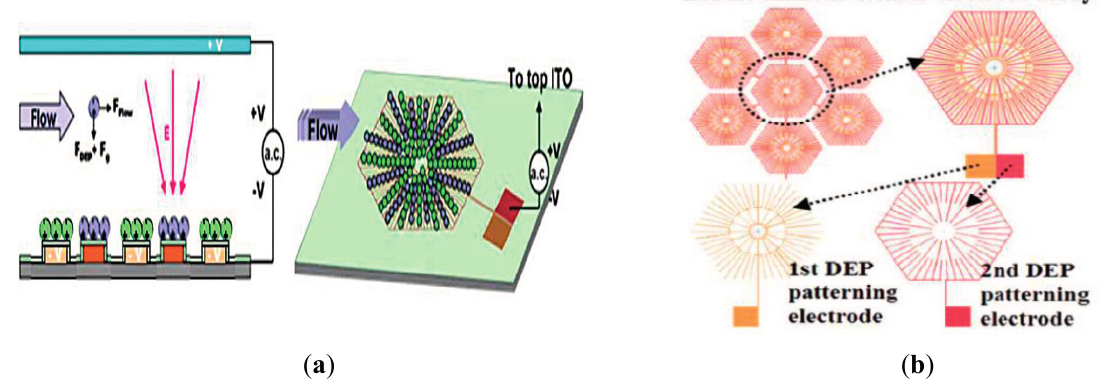
Figure 5. ( a ) Vertical setup for 3D heterogeneous cells patterning by DEP. ( b ) The lobule-mimetic-stellate-electrode arrays for 3D liver cell patterning. Reproduced with permission